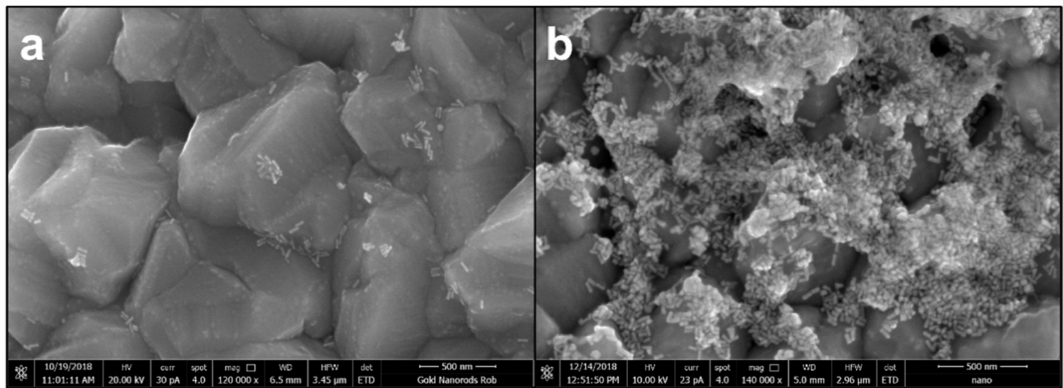
Figure 2. Scanning electron microscopy acquisitions of hexadecyltrimethylammonium bromide (CTAB)-gold nanorods (AuNRs) ( a ) and AuNRs / LA,GG ( b ) using magnifications 120,000 × ( a ) and 140,000 × ( b ). Scale bar: 500